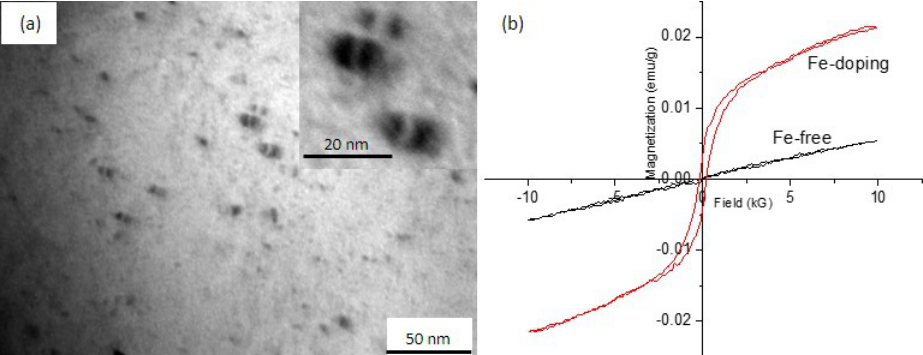
Alloy Table 1. Microstructural characterization of Fe-free and Fe-doping alloys at various temperatures.